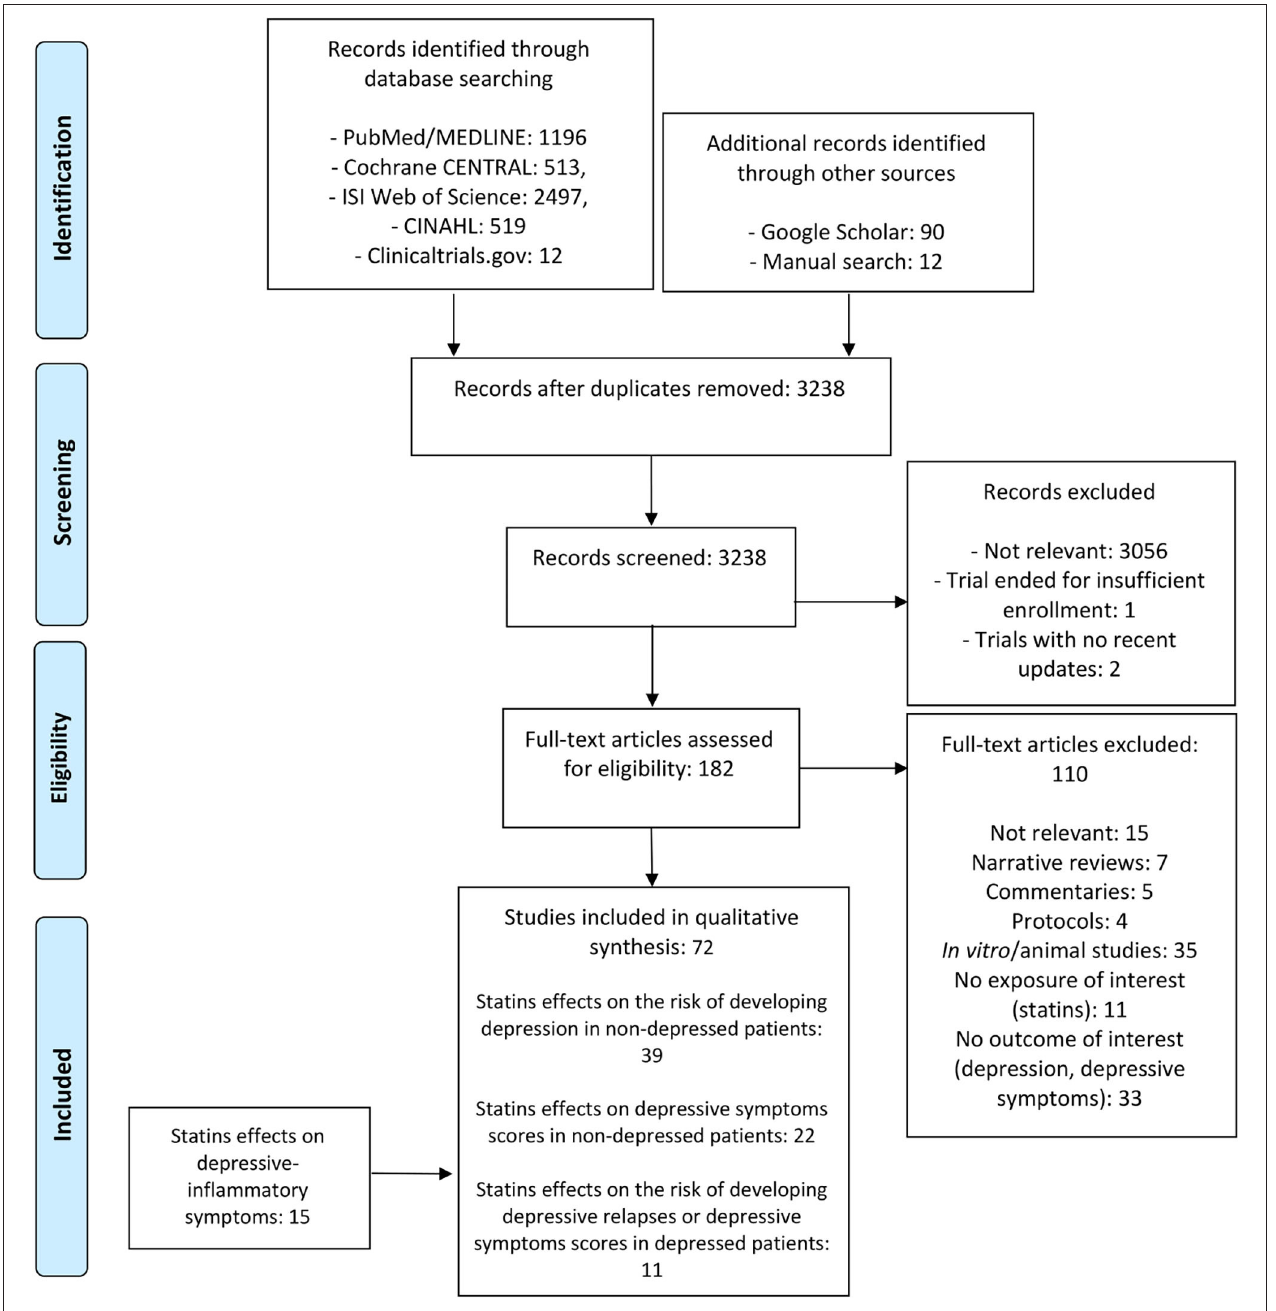
FIGURE 2 | Flow chart of the included/excluded